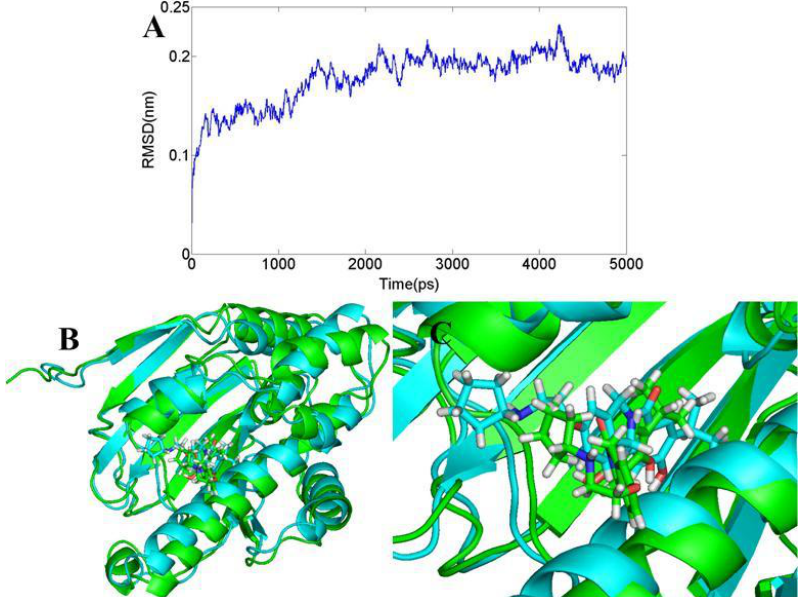
Figure 13. ( A ) Plot of the root-mean-square deviation (RMSD) of docked complex versus the MD simulation time in the MD-simulated structures; ( B ), ( C ) View of superimposed backbone atoms of the lowest energy structure of the MD simulation (cyan) and the initial structure (green) for compound 24-2XJG complex. Compound 24 is represented as carbon-chain in green for the initial complex and carbon-chain in cyan for the lowest energy